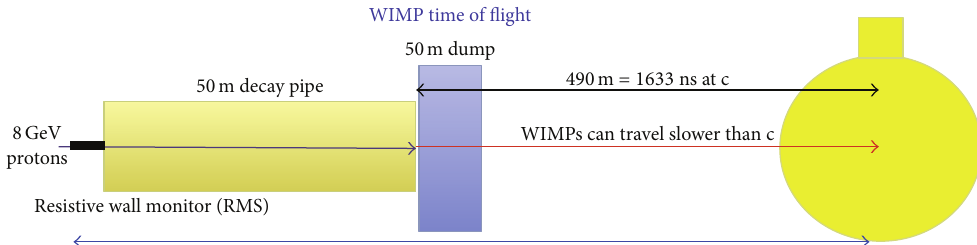
Figure 17: (Color online) The concept of dark matter particles TOF. Because of the localization of the dark matter particle production in time and in space, the dark matter beam has well-defined timing structure.